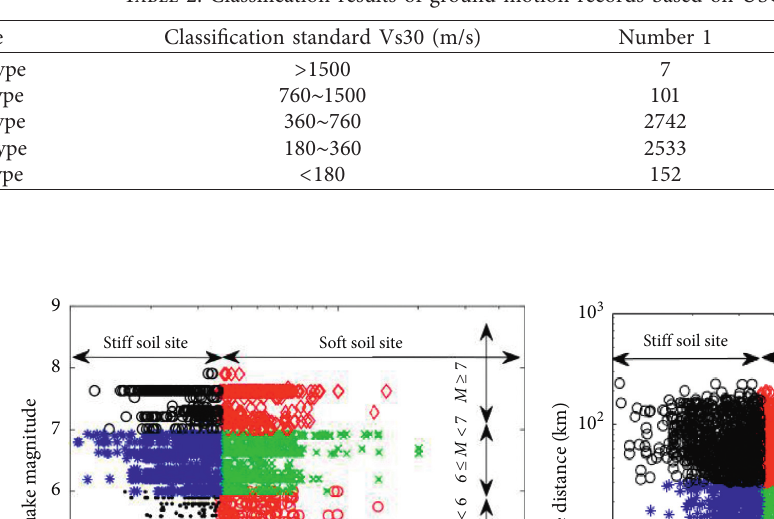
Table 2: Classification results of ground motion records based on USGS site classification.